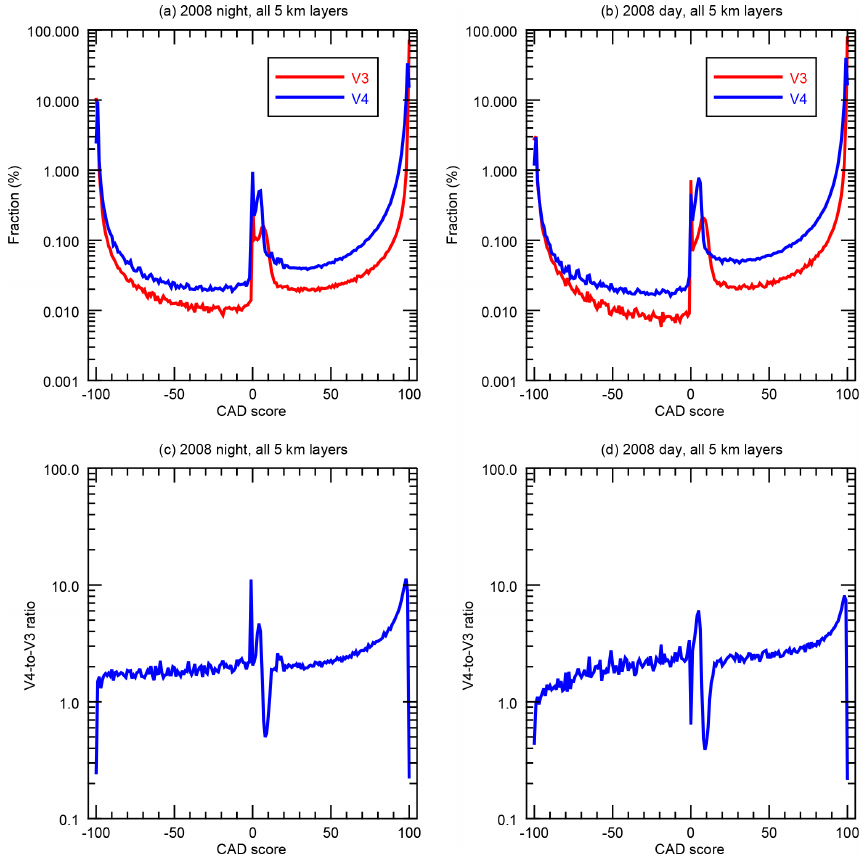
Figure 10. Distribution of occurrence frequencies (a, b) and their ratios (c, d) as a function of CAD score for all tropospheric layers detected at a 5km resolution for 2008 V3 and V4, for nighttime (a, c) and daytime data (b, d) . Table 2. Comparison of V3 and V4 CAD scores for all 5km layers for the year 2008. Aerosol faction (%) Cloud fraction (%) High confidence (%) Total layers CAD − 100 − 98 to − 100 < − 70 All